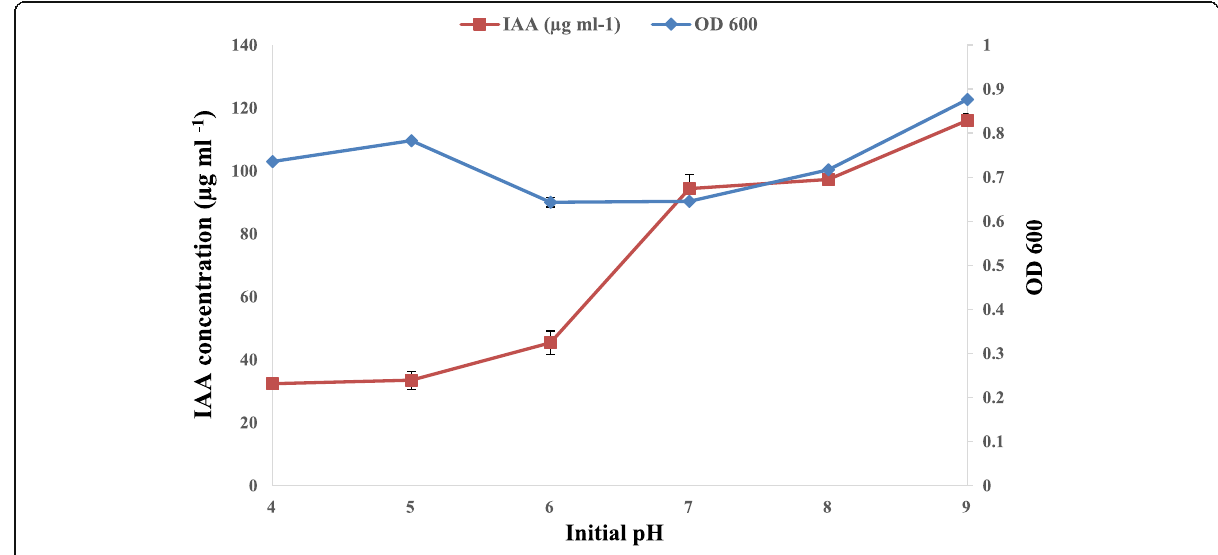
Fig. 3 Effect of different pH values on Rhizobium sp . growth and IAA production